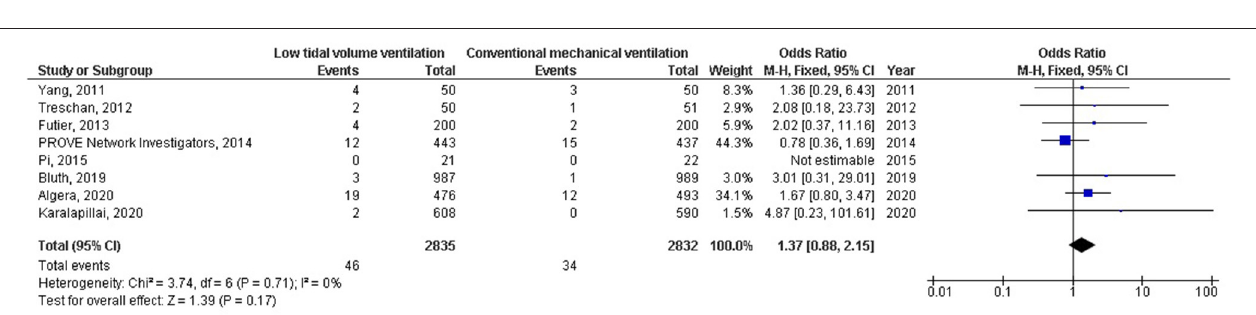
FIGURE 7 | Forest plot of the low tidal volumes strategy vs. conventional mechanical ventilation in subjects undergoing surgery on acute respiratory distress.